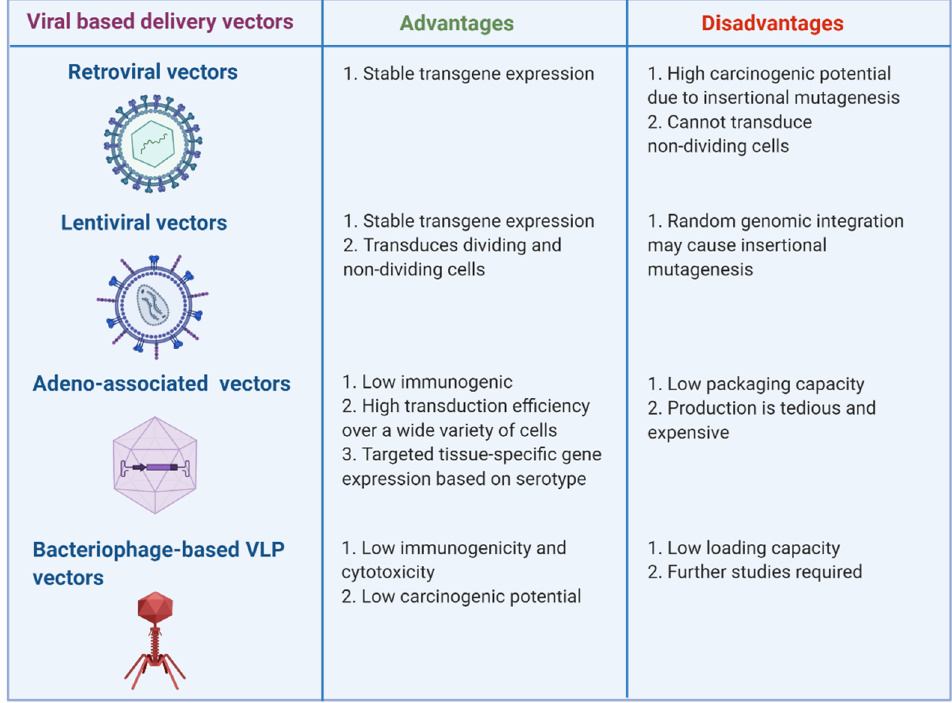
Figure 1. Key advantages and disadvantages of virus-based vectors used for miRNA delivery are highlighted. Viral vectors represented here include retroviral, lentiviral, adeno-associated, and bacteriophage-based VLP vectors. Figure was created with BioRender.com.